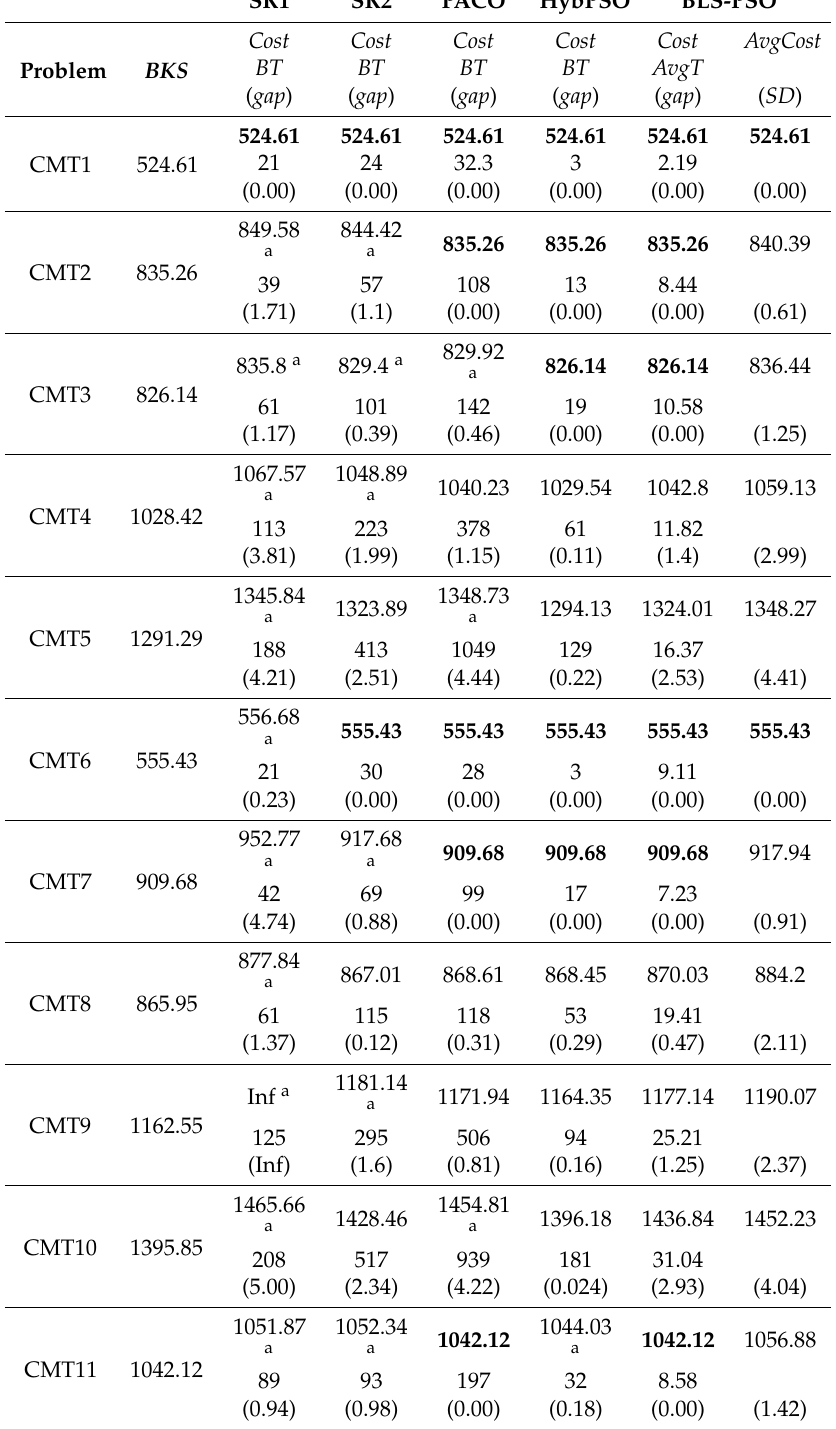
Table 12 portrays the comparison of performance in handling CMT problem set instances. Here we have compared SR1, SR2 [44,46], HybPSO [47] and PSCO [52] with the proposed BLS-PSO. Table 12. Performance comparison of BLS-PSO with respect to other PSO-based approaches for solving the instances of Set